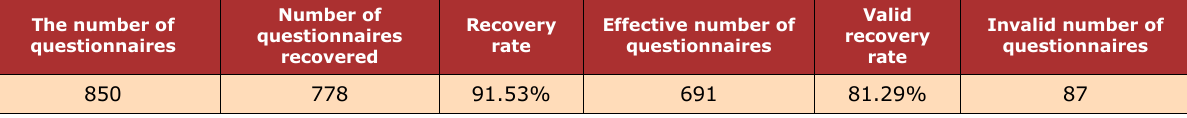
Table 2. List of the research questionnaires recovery